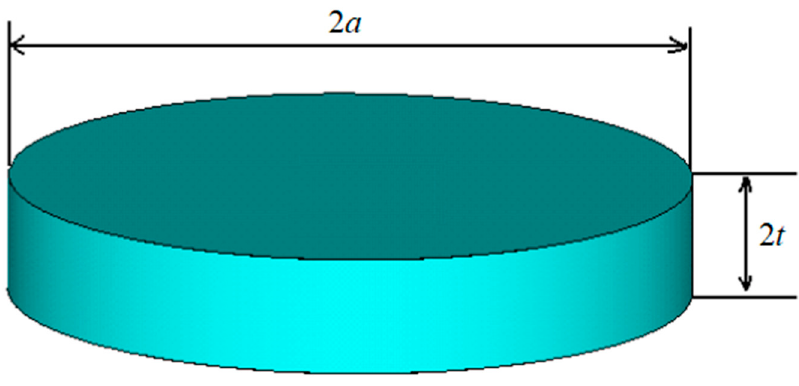
Figure 1. Disc piezoelectric ceramics.